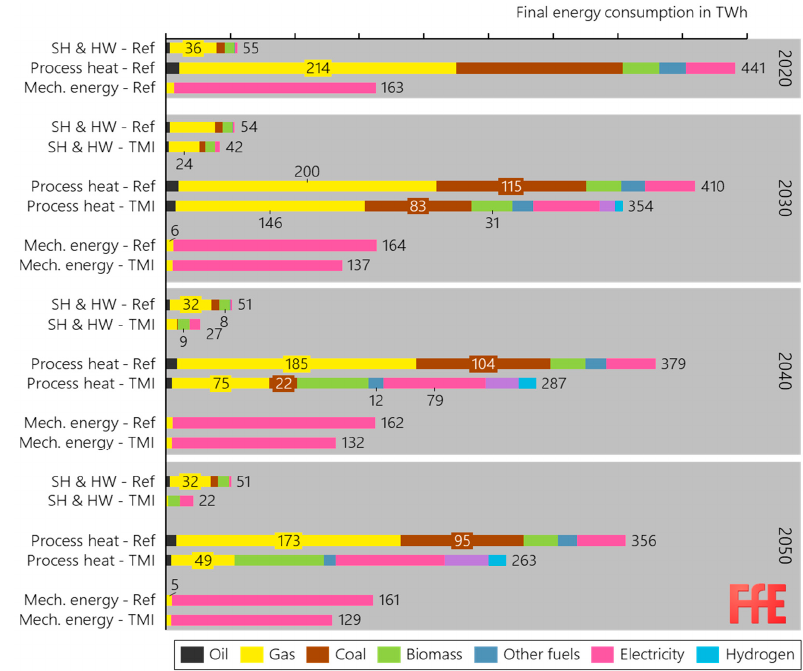
Figure A2. Energy consumption by fuel application and energy carrier in Reference and TMI scenarios between 2020 and 2050 (SH & HW: Space Heating and Hot Water). Energies 2020 , 13 , x FOR PEER REVIEW